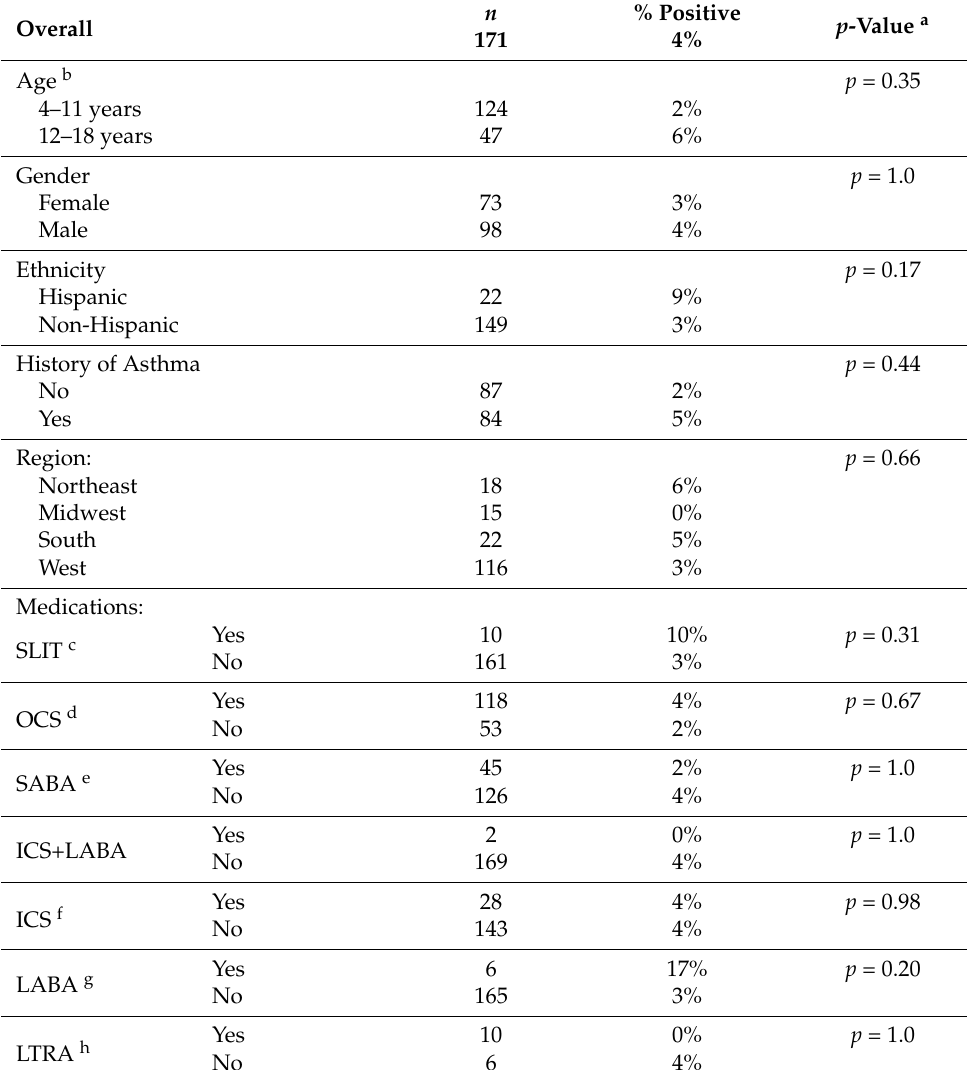
Table 1. Patient characteristics described in relation to positive SARS-CoV-2